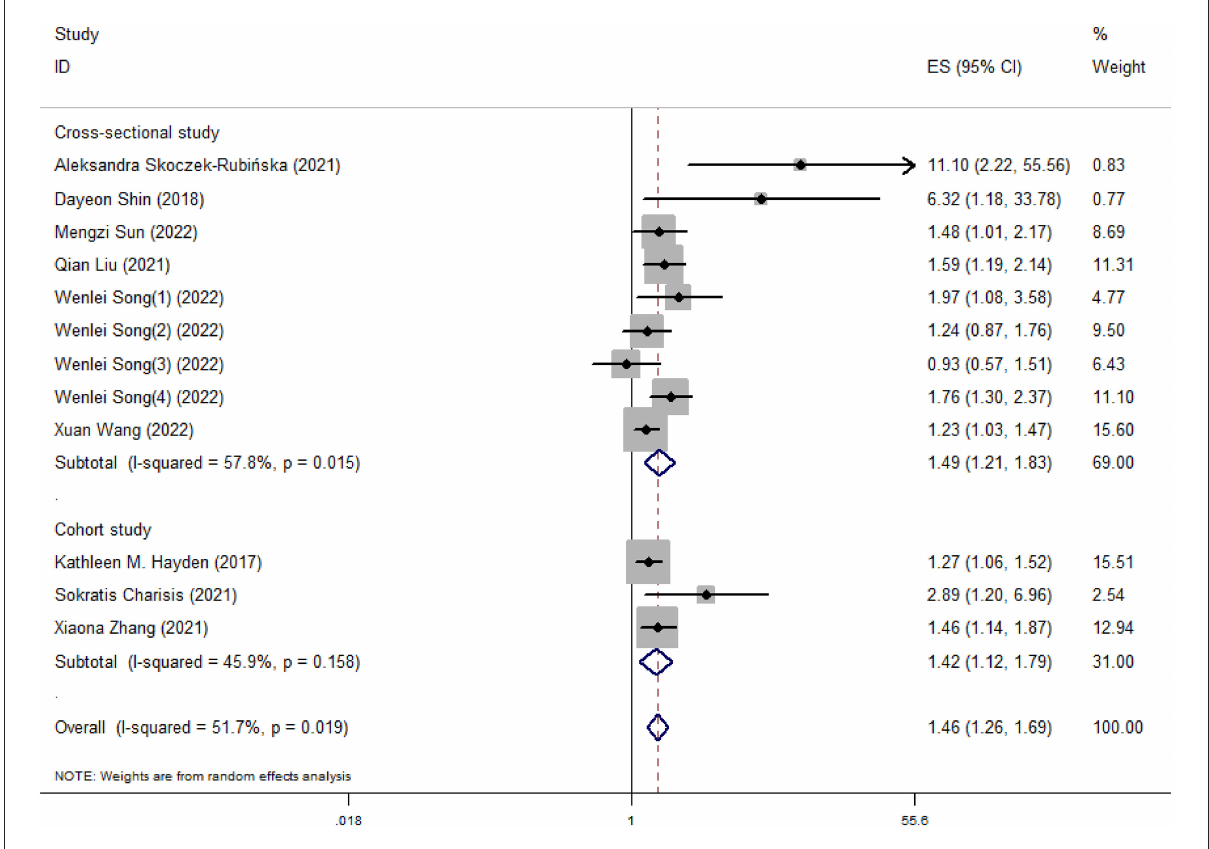
FIGURE3 Meta-analysis results of higher DII for the risk of cognitive impairment (subtotals on the basis of study